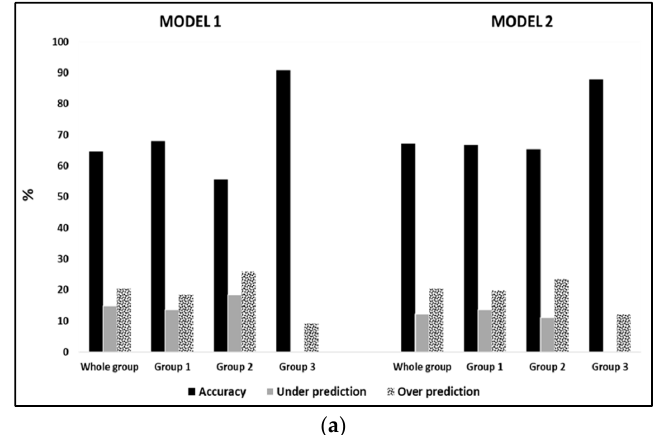
Table 5. Bias (mean percentage error between predicted and measured REE) for the new predictive equations in the entire study groups as well as BMI subgroups. Bias (Mean Percentage Difference between Predicted and Measured